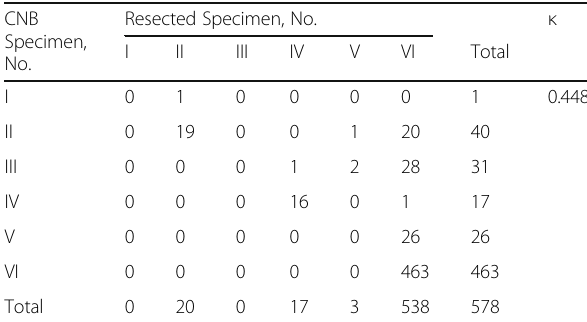
Table 2 Comparison Between the Classification of Thyroid Nodules based on CNB and Resected Specimens from Six- Classification Method